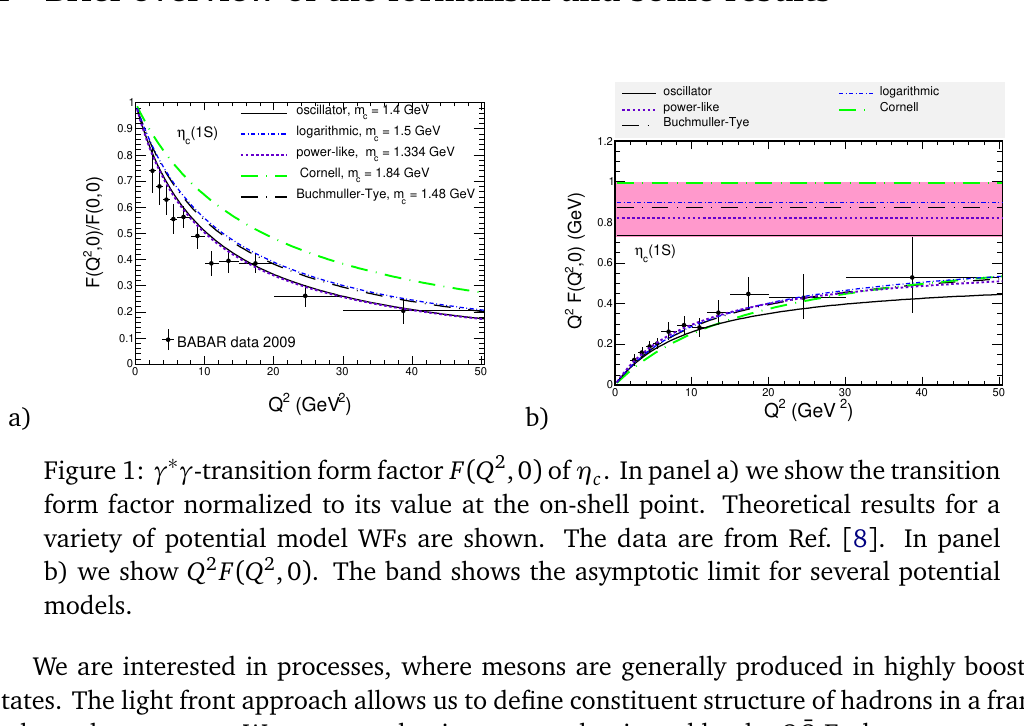
Figure 1: γ ∗ γ -transition form factor F ( Q 2 ,0 ) of η form factor normalized to its value at the on-shell point. Theoretical results for a variety of potential model WFs are shown. The data are from Ref. [ 8 ] . In panel b) we show Q 2 F ( Q 2 ,0 ) . The band shows the asymptotic limit for several potential